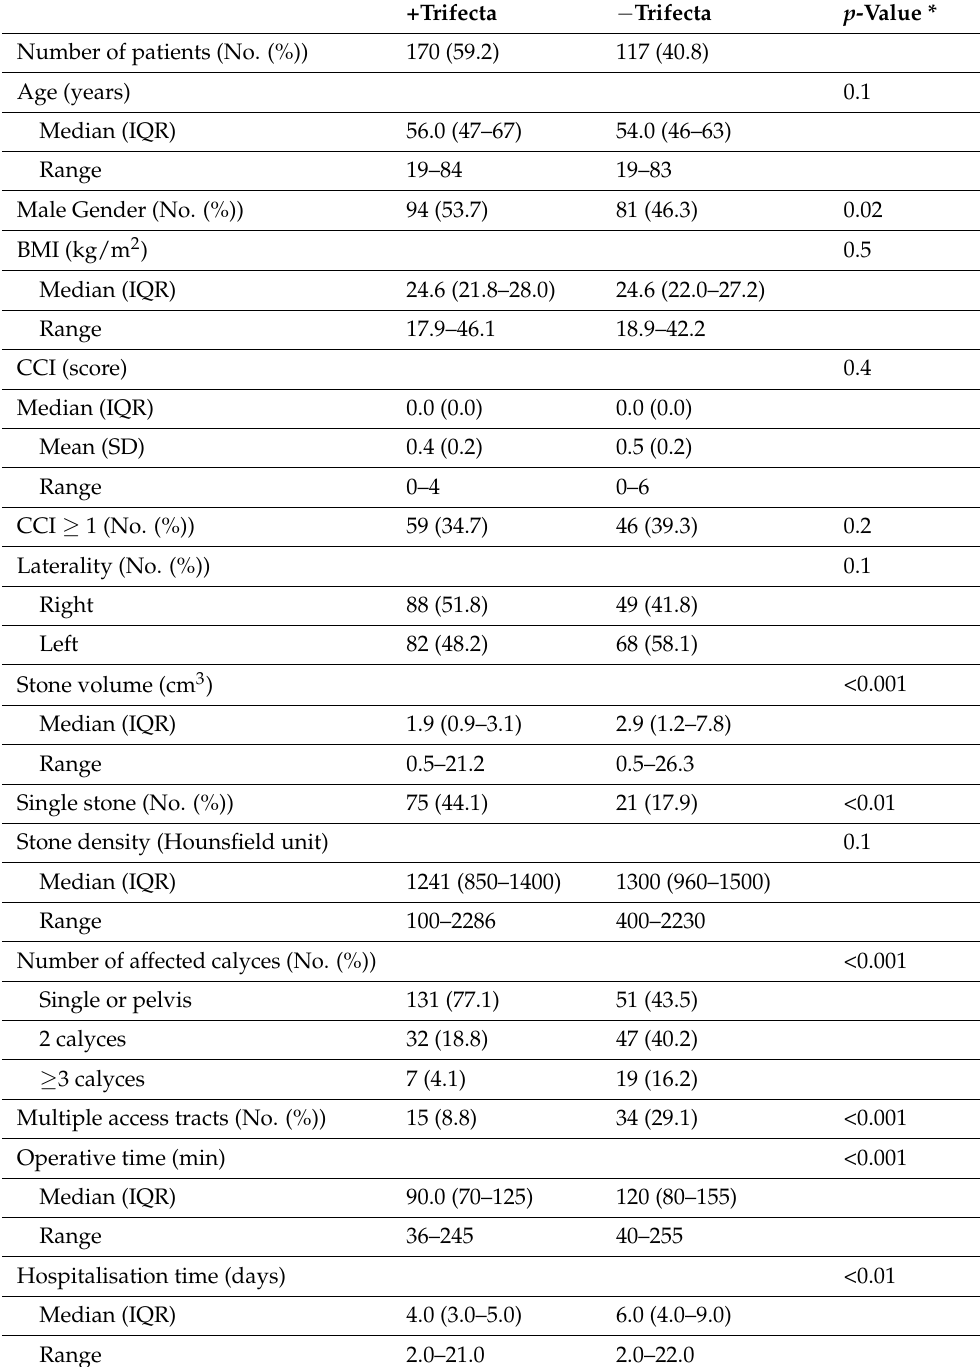
Table 2. Descriptive statistics of the whole cohort as segregated according to trifecta achievement ( n =